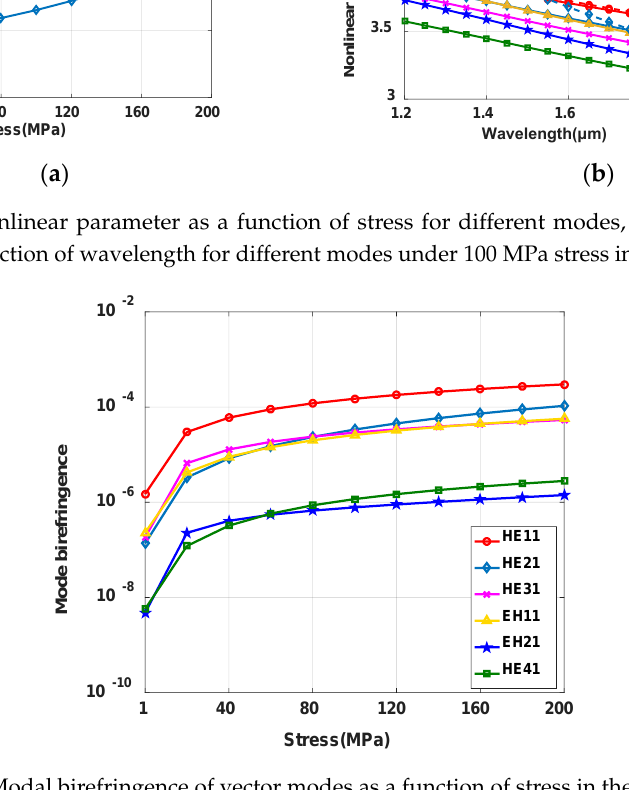
Figure 17. Modal birefringence of vector modes as a function of stress in the y direction.